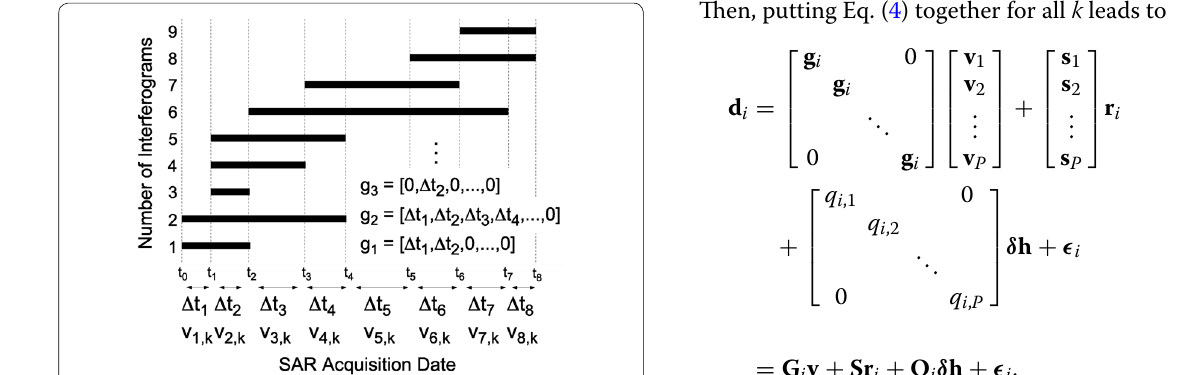
Fig. 15 Schematic showing the relationship between interferograms and time steps on which model velocities are solved for. In this example, N = 9 and M =